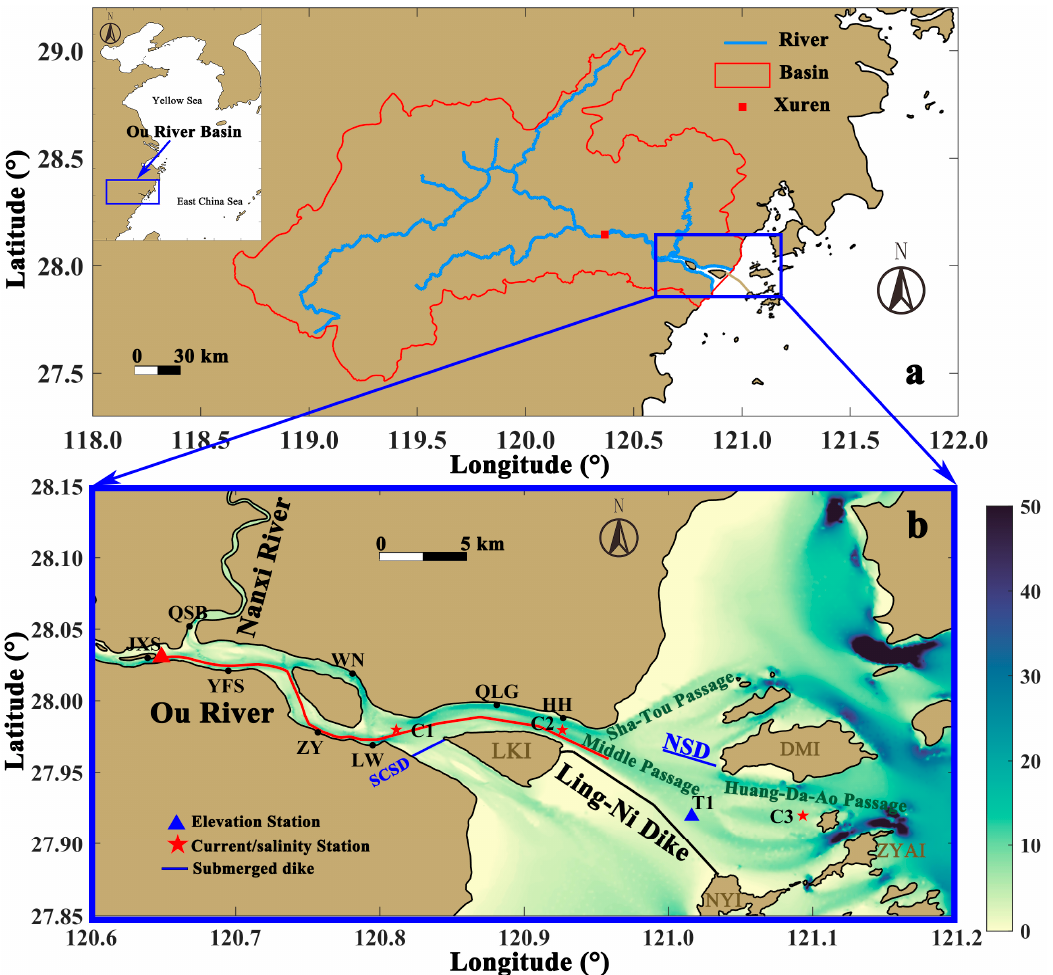
Figure 1. ( a ) The Ou River Basin with the Xuren hydrologic station. ( b ) Zoom-in of the blue box in ( a ); bathymetry of the ORE (color, unit: m). The red line is the along-channel section used in this study. LKI: Ling-Kun Island; DMI: Da-Men Island, NYI: Ni-Yu Island; ZYAI: Zhuang-Yuan-Ao Island; NSD: North Submerged Dike; SCSD: South Channel Submerged Dike; JXS: Jiang-Xin-Si; QSB: Qing-Shui-Bu; ZY: Zhuang-Yuan; WN: Wu-Niu; LW: Long-Wan; QLG: Qi-li-Gang; HH: Huang-Hua.